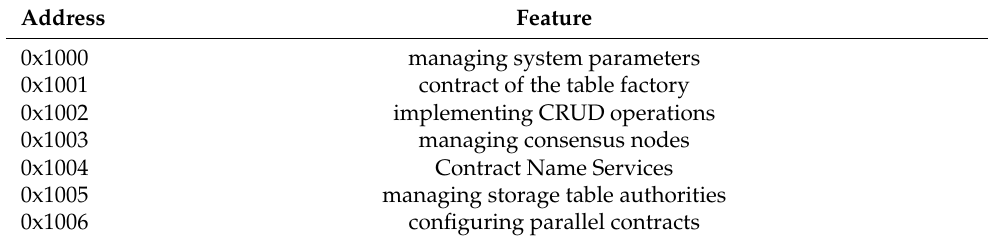
Table 5. Precompiled contracts in FISCO BCOS